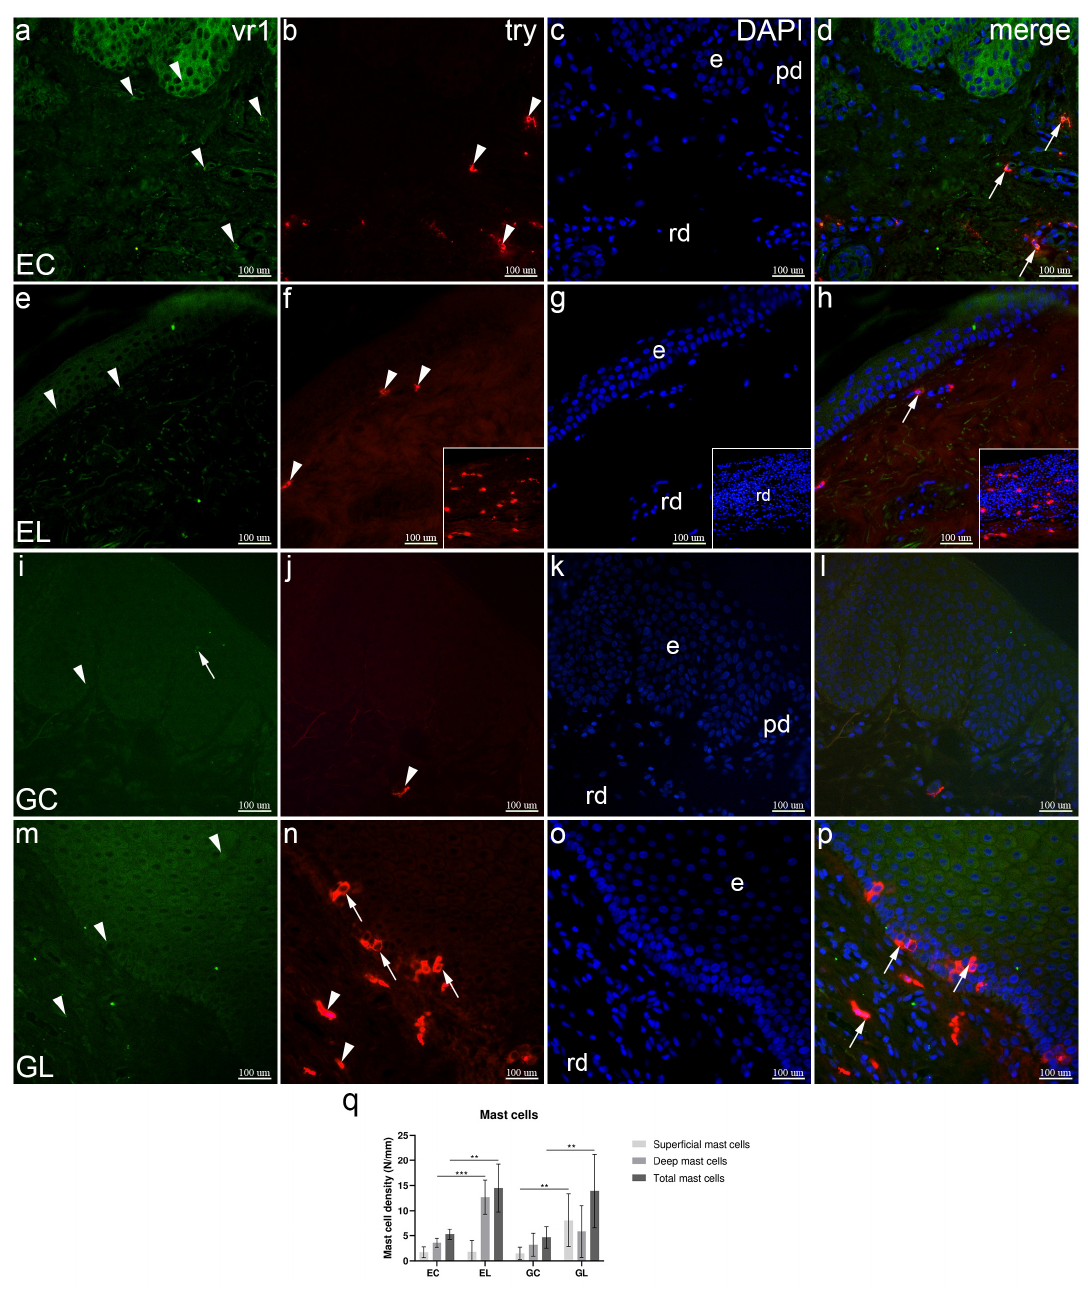
Figure 4. Co-expression of VR1 and tryptase (try) in normal skin and lichen sclerosus skin samples. The epidermis (e), papillary dermis (pd), and reticular dermis (rd) are marked on DAPI staining images which display all cell nuclei ( c , g , k , o ). EC—normal extragenital skin ( a – d ): VR1 expression is observed in keratinocytes and dermal cells (arrowheads, ( a )); tryptase staining displays dermal mast cells (arrowheads, ( b )); VR1 and tryptase are co-expressed in mast cells (arrows, ( d )). EL—extragenital skin affected by lichen sclerosus ( e – h ): keratinocytes and dermal cells show VR1 expression (arrow- heads, ( e )); dermal mast cells express tryptase (arrowheads, ( f )); co-expression of VR1 and tryptase is observed in a mast cell (arrow, ( h )); insets demonstrate a mast cell infiltrate in the reticular dermis ( f – h ). GC—normal vulvar skin ( i – l ): keratinocytes (arrowhead) and a nerve fiber (arrow) show VR1 expression ( i ); a dermal cell shows tryptase staining (arrowhead, ( j )); no co-expression is observed in the merged image ( l ). GL—vulvar skin affected by lichen sclerosus ( m – p ): VR1 is expressed in keratinocytes and dermal cells (arrowheads, ( m )); dermal (arrowheads) and intraepidermal